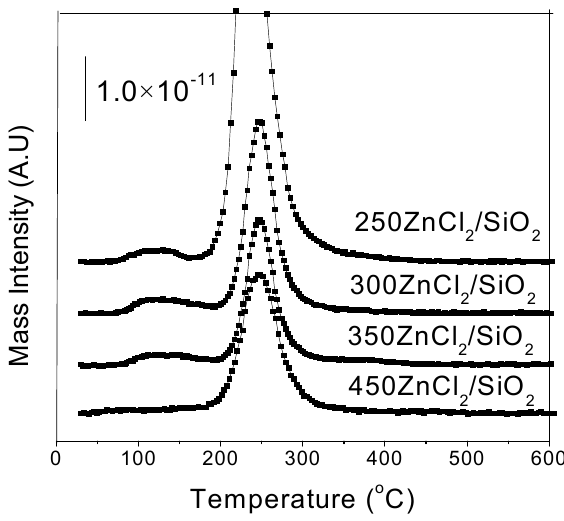
Figure 3. Acrolein in the TPSR of Lewis acid catalysts.